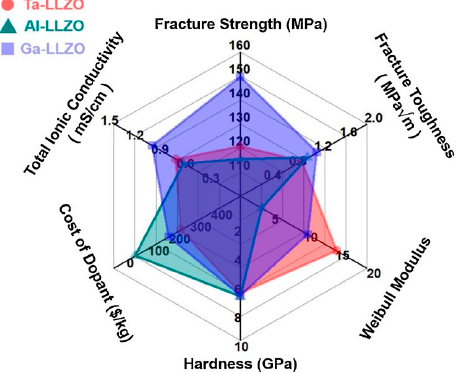
Figure 24. Spider chart of mechanical and electrical properties of hot-pressed Ta-LLZO, Al-LLZO, and Ga-LLZO. Here, LLZO denotes Li 6.25 La 3 Al 0.25 Zr 2 O 12 . Reproduced with permission from [355].